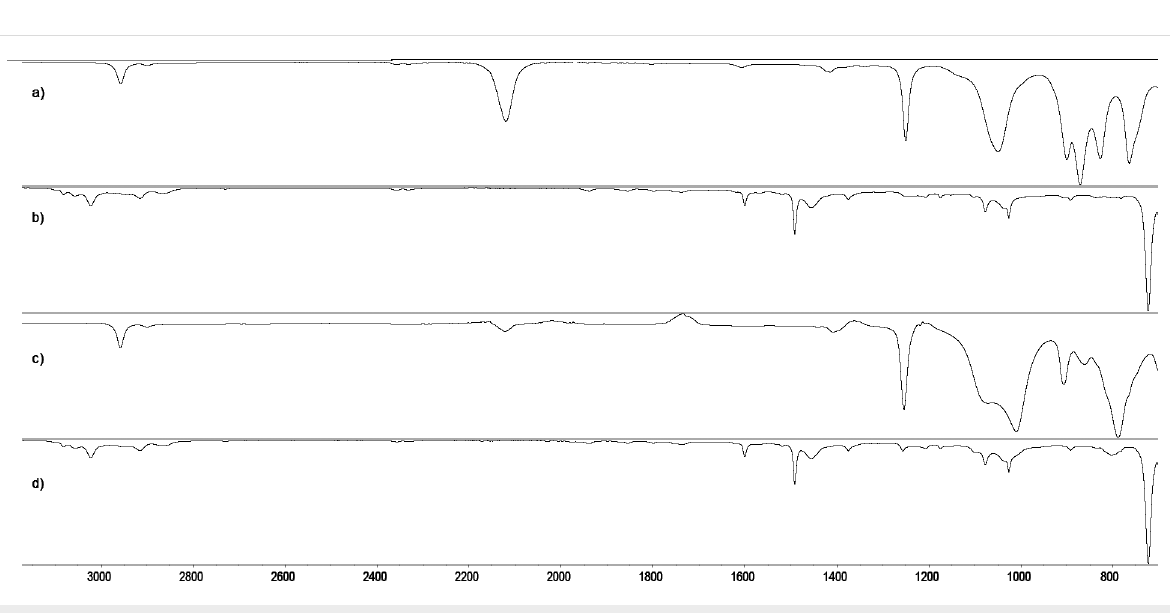
Figure 1: IR spectra of (a) H-terminated disiloxane ( 1 ), (b) α -CD-terminated disiloxane ( α -CD-disiloxane) ( 4 ), (c) H-terminated polydimethylsiloxane ( 2 ) and (d) α -CD-terminated polydimethylsiloxane ( α -CD-PDMS) ( 5